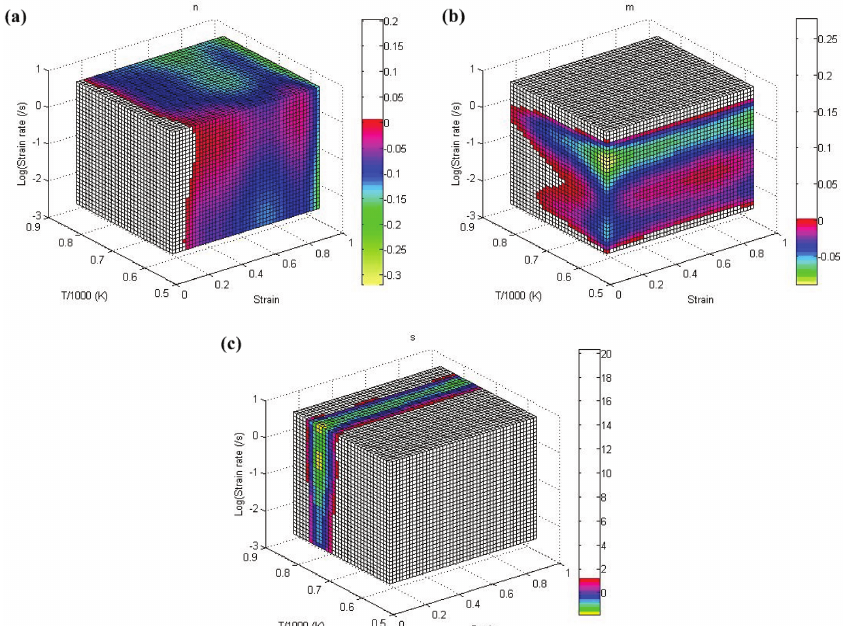
Figure 12: 3D dynamic instability maps: (a) n ð ε , _ ε , T Þ ; (b) m ð ε , _ ε , T Þ ; (c) s ð ε , _ ε , T Þ